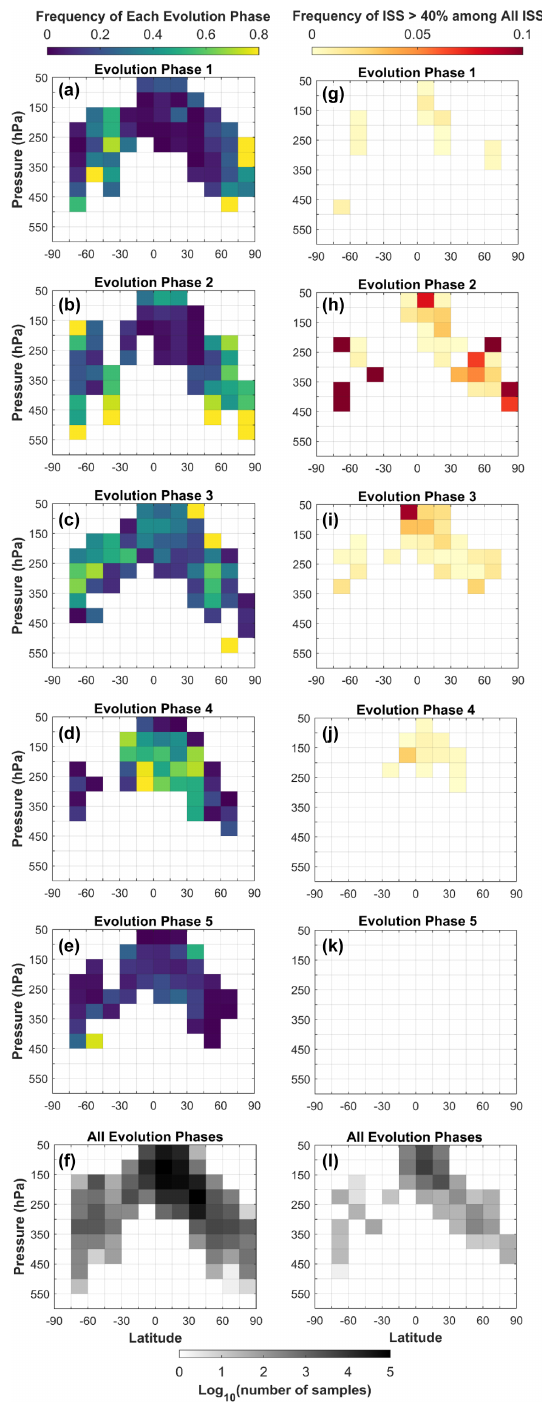
Figure 5. The hemispheric distribution of the occurrence frequen- cies of (a–e) each evolution phase and (g–k) RHi > 140% among all ice-supersaturated conditions in each phase. (f) Number of sam- ples for five evolution phases. (l) Number of samples for all ISS conditions in five phases. This analysis is based on combined NSF and NASA